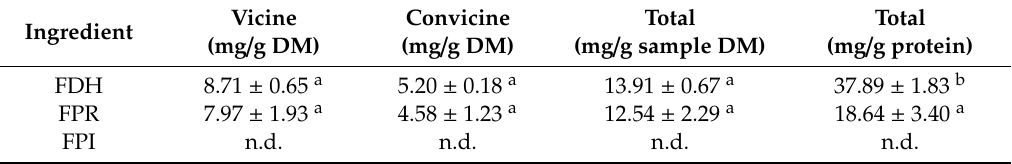
Table 6. Content of the antinutritional compounds vicine and convicine in faba bean ingredients 1 . Ingredient